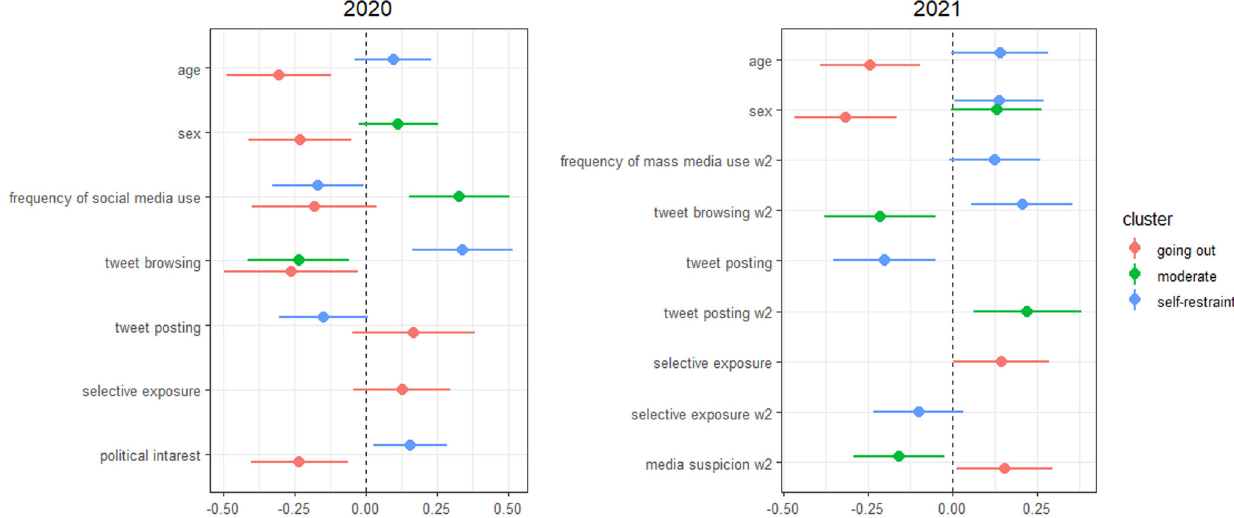
Fig. 2 Variables used to predict cluster af fi liations at each time point. Left: First wave in 2020; Right: Second wave in 2021. The panels show variables selected by stepwise methods and standardised coef fi cients with 95% con fi dence intervals. The variables in the second wave are suf fi xed ‘ w2 ’ , and the variables without suf fi x are in the fi rst wave.